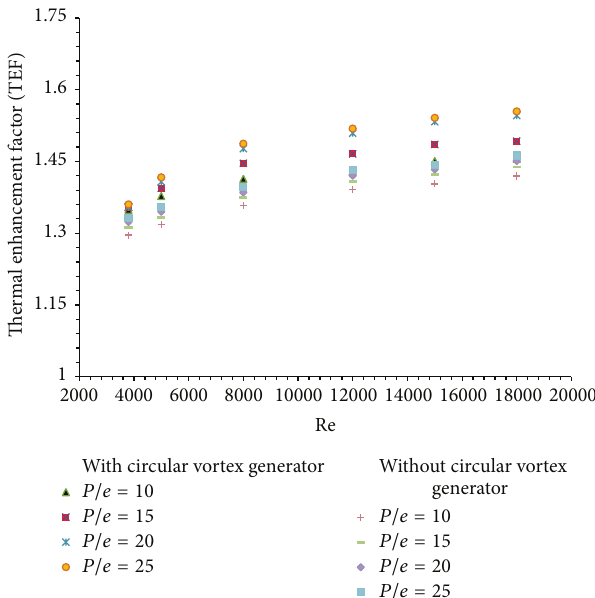
Figure 12: Variation of thermal enhancement factor (TEF) with Reynolds number